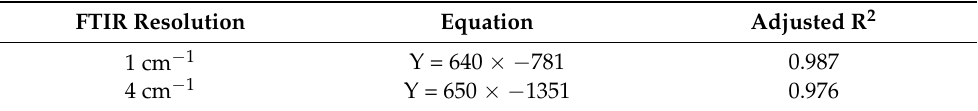
Table 2. The linear fitting comparison between FTIR resolution of 1 cm − 1 and 4 cm − 1 . FTIR